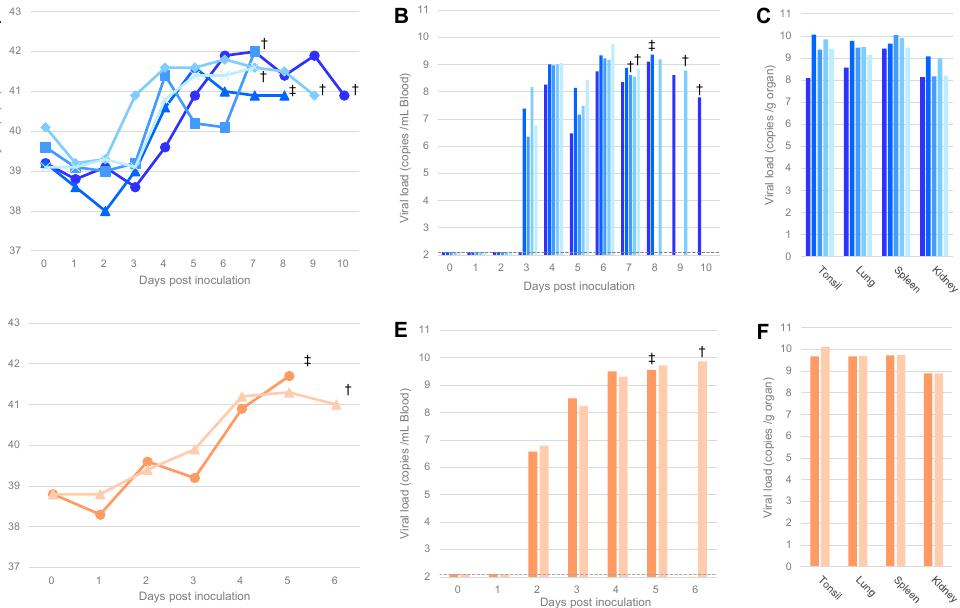
Figure 2. Body temperature and viral load of pigs inoculated with the isolated viruses. The body temperature ( A , D ) and viral copy numbers in the blood ( B , E ) and organs ( C , F ) of pigs inoculated with AQS-C-1-22 (blue, A – C ) or AQS-P-20901-1 (orange, D – F ) are shown. The identification numbers of pigs are indicated by the shape of markers or sorting order of bars: Nos. 1–5 are indicated by circles, triangles, squares, rhombi, and crosses ( A ) or ordered from left to right ( B , C ), respectively. Each symbol means euthanasia by humane endpoint (†) or death (‡), and the broken lines in B and E indicate the detection limit (=100 copies/mL of blood).